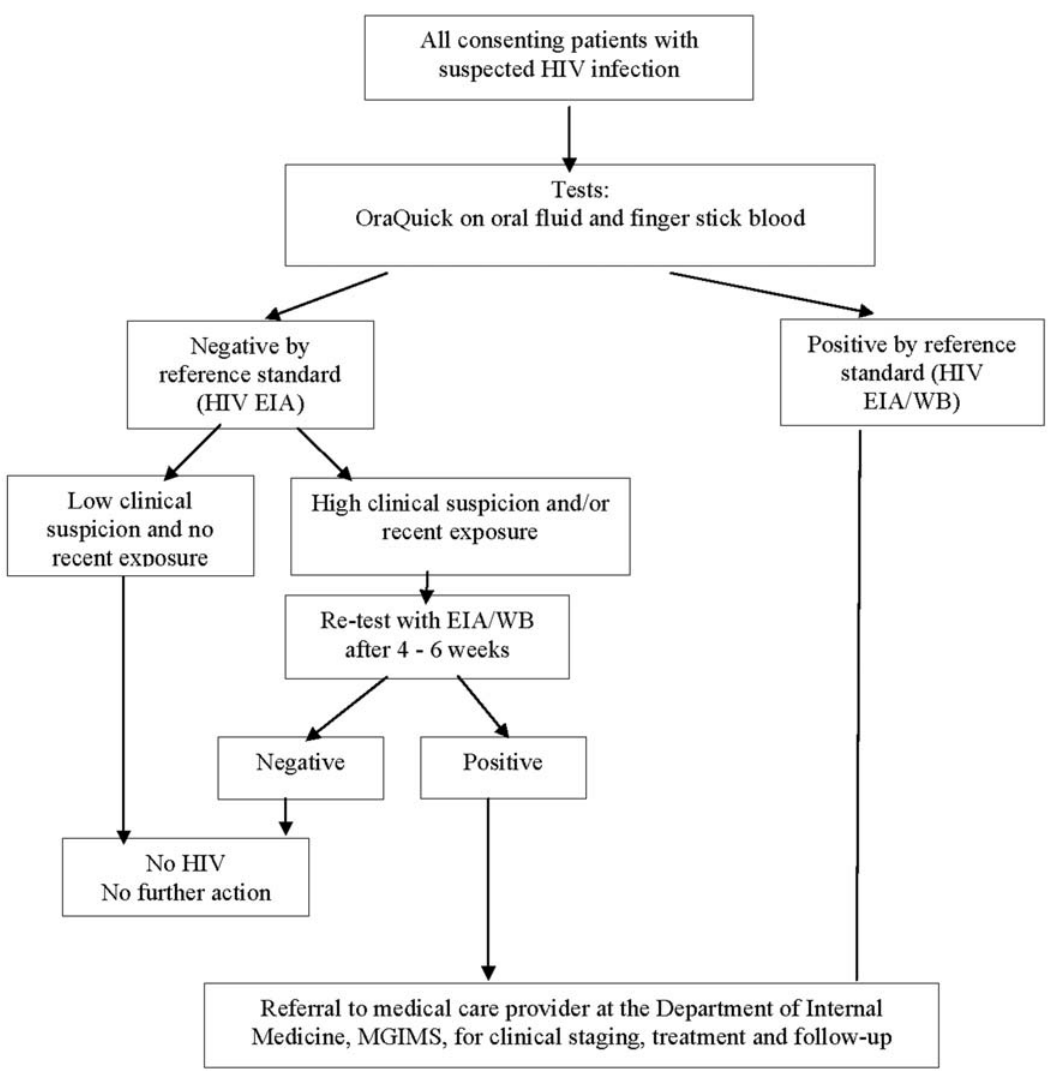
Figure 1. HIV Testing Algorithm